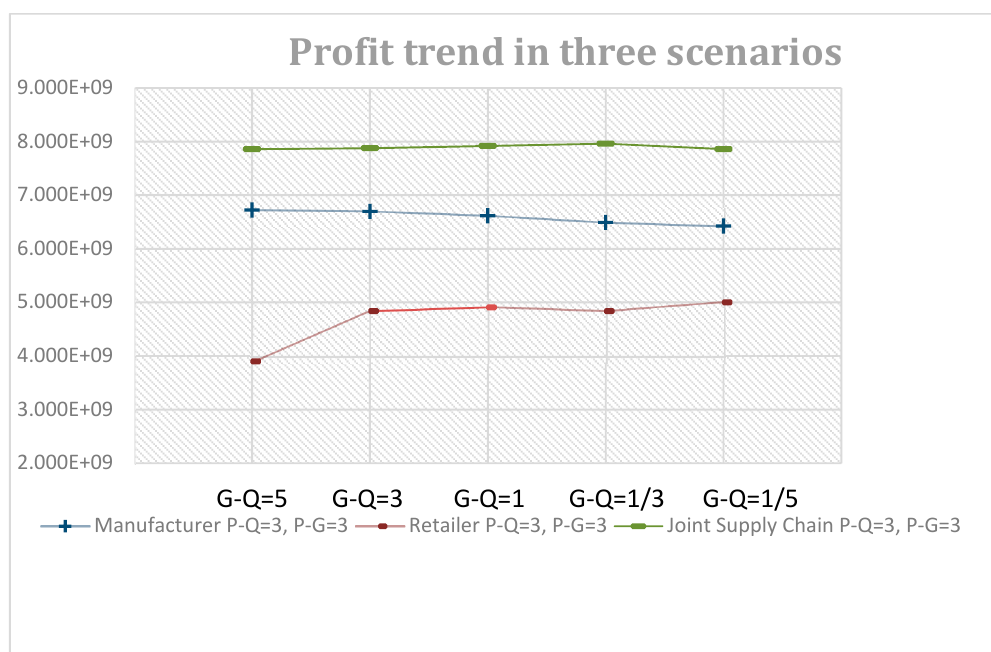
Figure 8. Profit trend of manufacturer, retailer, and joint supply chain when P-Q=3, P-G=3.